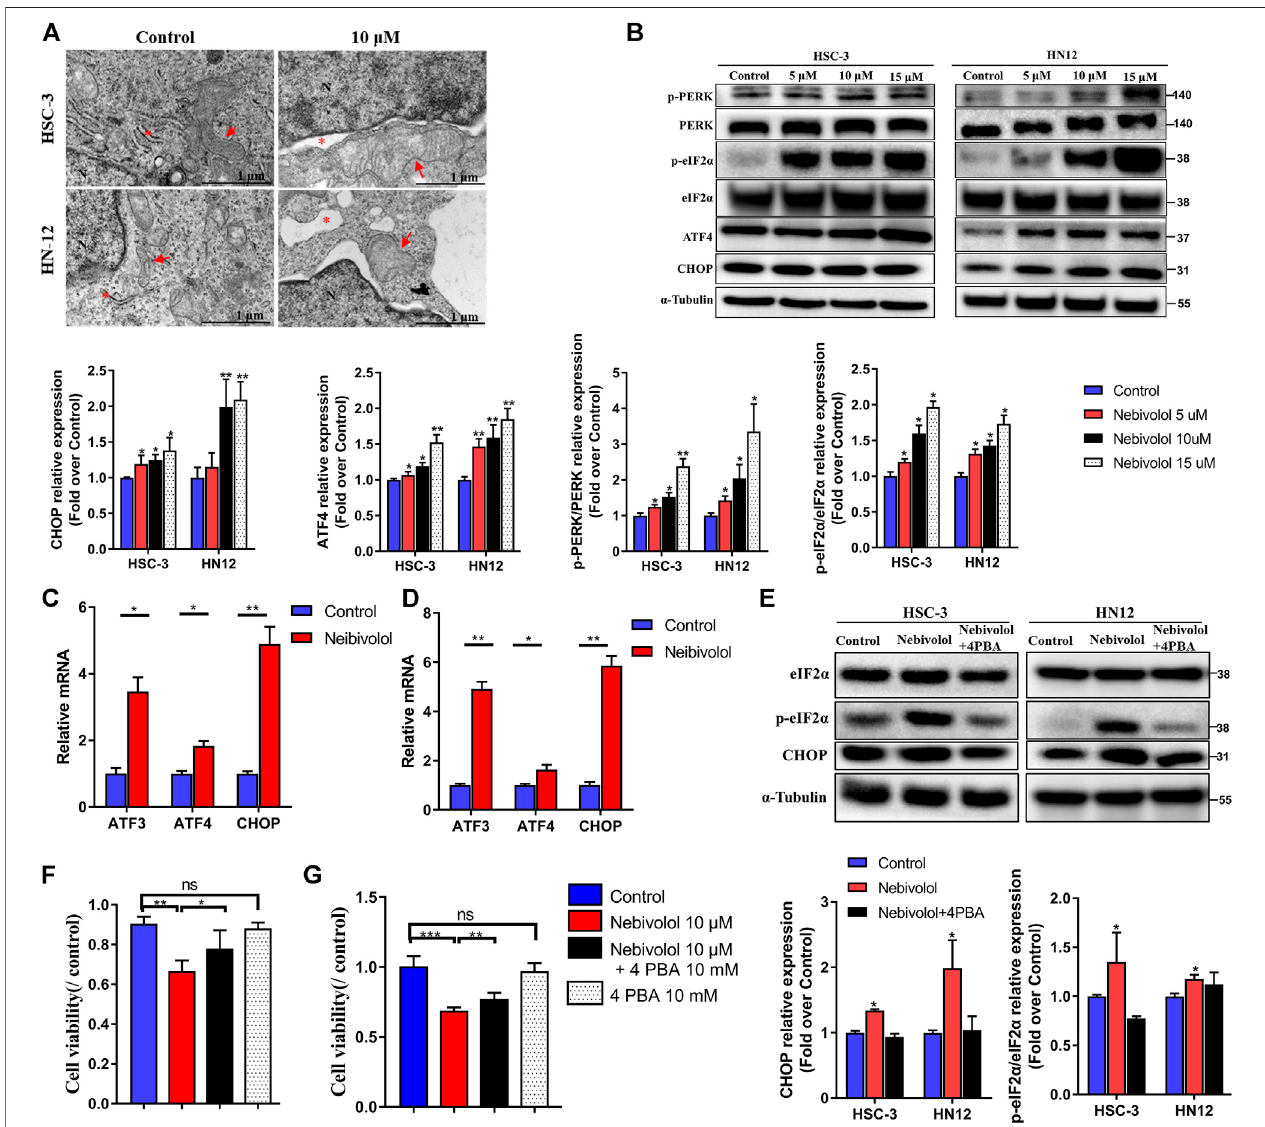
FIGURE 4 | Nebivolol activated apoptosis via ER stress signaling pathway in OSCC cells. (A) Representative images of cytoplasmic vacuoles detected by TEM in OSCC cells after being treated with nebivolol and controls. Massive cytoplasmic vacuolization was visible which was derived from enlarged ER and mitochondria after beingtreatedwithisorhamnetin.Redarrows:ER;Redasterisks:mitochondria.Scalebar (cid:2) 1 μ M. (B) WesternblottingofERstressmarkerswasexaminedinOSCCcells after being treated with the indicated concentrations of nebivolol. The p-PERK, p -eIF2 α , ATF4, and CHOP from the blots were quanti fi ed. (C, D) The qRT-PCR analysis con fi rmed that ER stress gene expression was upregulated in HSC-3 cells (C) and HN12 cells (D) . (E) Western blotting of total and phosphorylated eIF2 α and CHOP in OSCC cells after treatment with or without nebivolol in the presence or absence of 4-PBA. The p -eIF2 α and CHOP from the blots were quanti fi ed. (F – G) The CCK-8assaywasusedtodeterminethecellviabilityofnebivololinthepresenceorabsenceof4-PBAonHSC-3 (F) andHN12cells (G) .Datarepresentthemean ± SDof three replicate independent experiments. The asterisk (*) indicates a signi fi cant difference compared to the control group (* p < 0.05, ** p < 0.01, and *** p < 0.001).